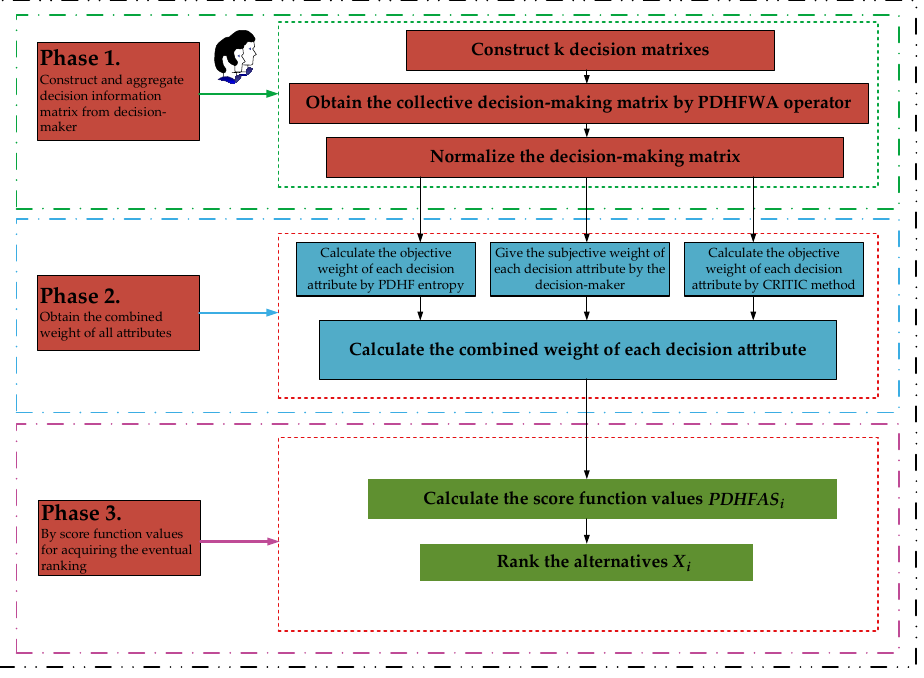
Figure 1. Flowchart of the developed PDHF MAGDM approach